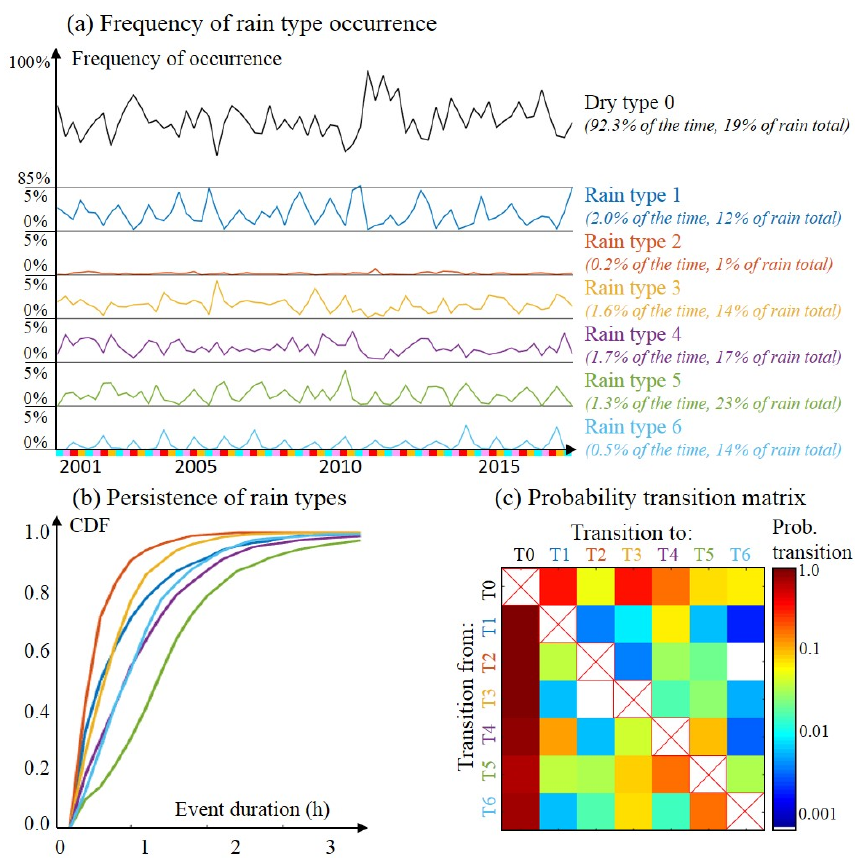
Figure 3. Main features of a rain type time series (2001–2017) observed over central Germany. (a) Frequency of rain type occurrence computed at a seasonal basis (seasons are December, January and February – DJF – in light blue; March, April and May – MAM – in pink; June, July and August – JJA – in red; and September, October and November – SON – in yellow). (b) CDF of event duration stratified by rain type. (c) Empirical matrix of transition probability between rain